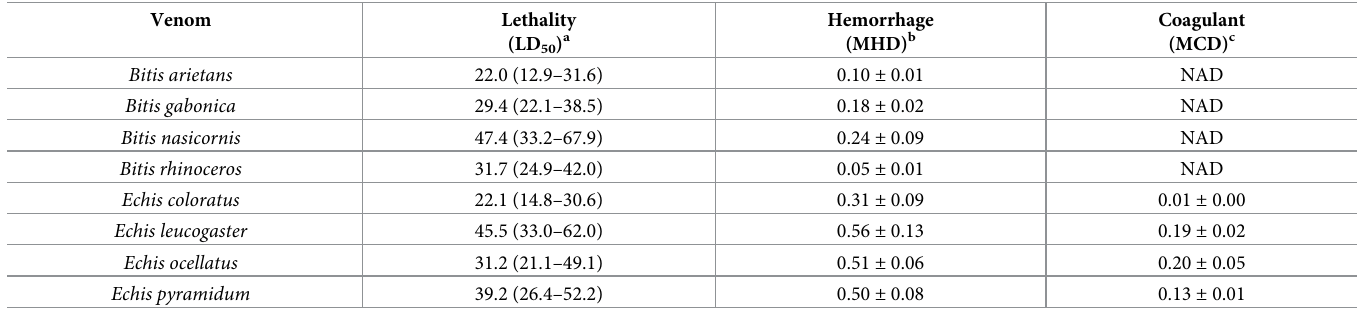
Table 1. Toxic activities of venoms of African Bitis and Echis